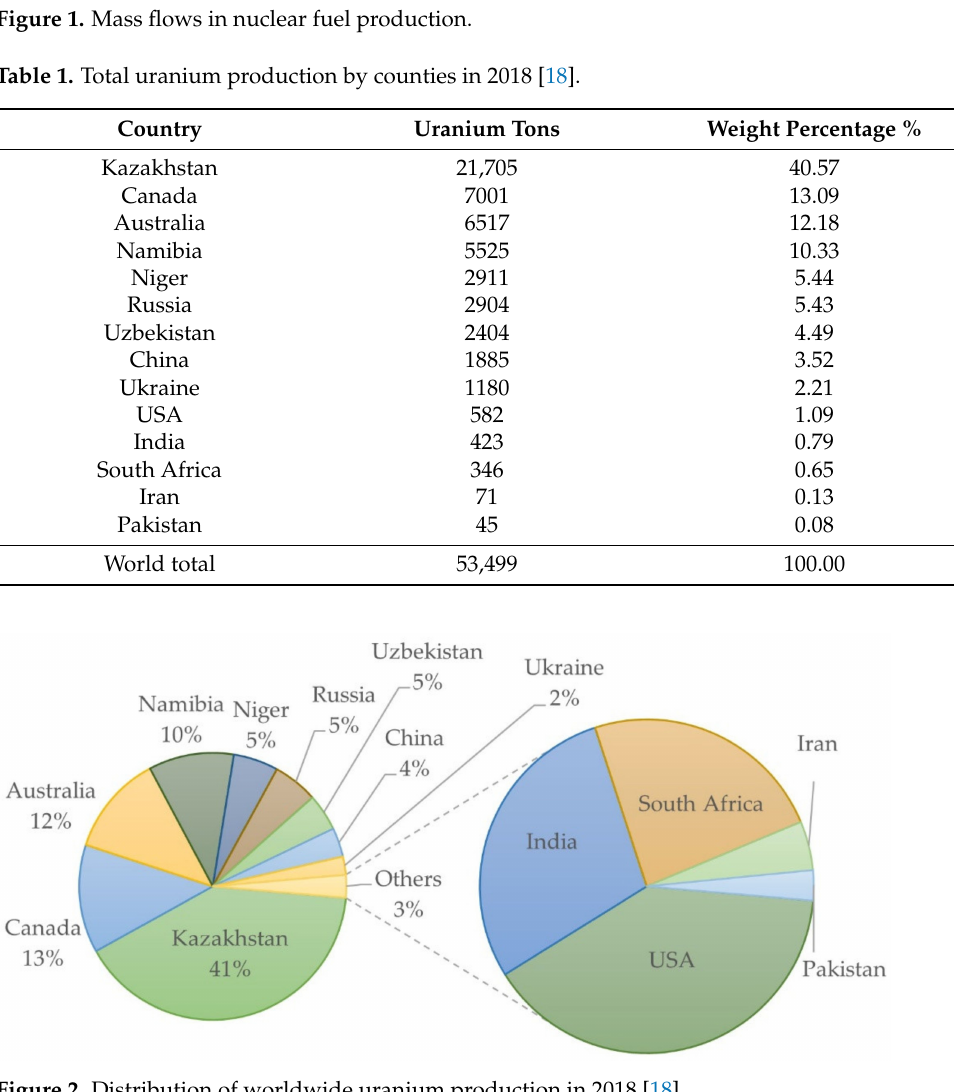
Figure 2. Distribution of worldwide uranium production in 2018